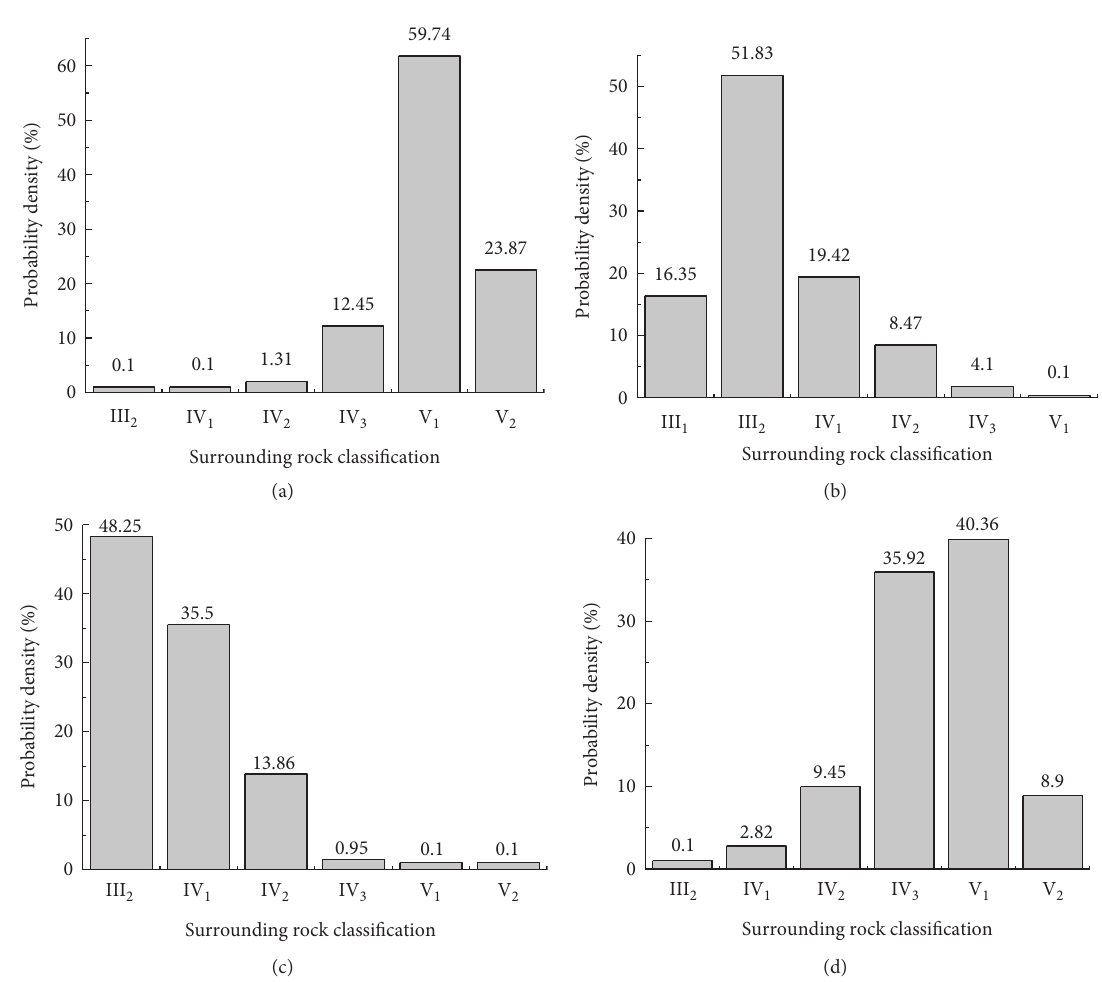
Figure 7: Probability classification results of surrounding rock. (a) K94 +653 ∼ 683. (b) K94 +713 ∼ 743. (c) K94+743 ∼ 773. (d) K94+816 ∼